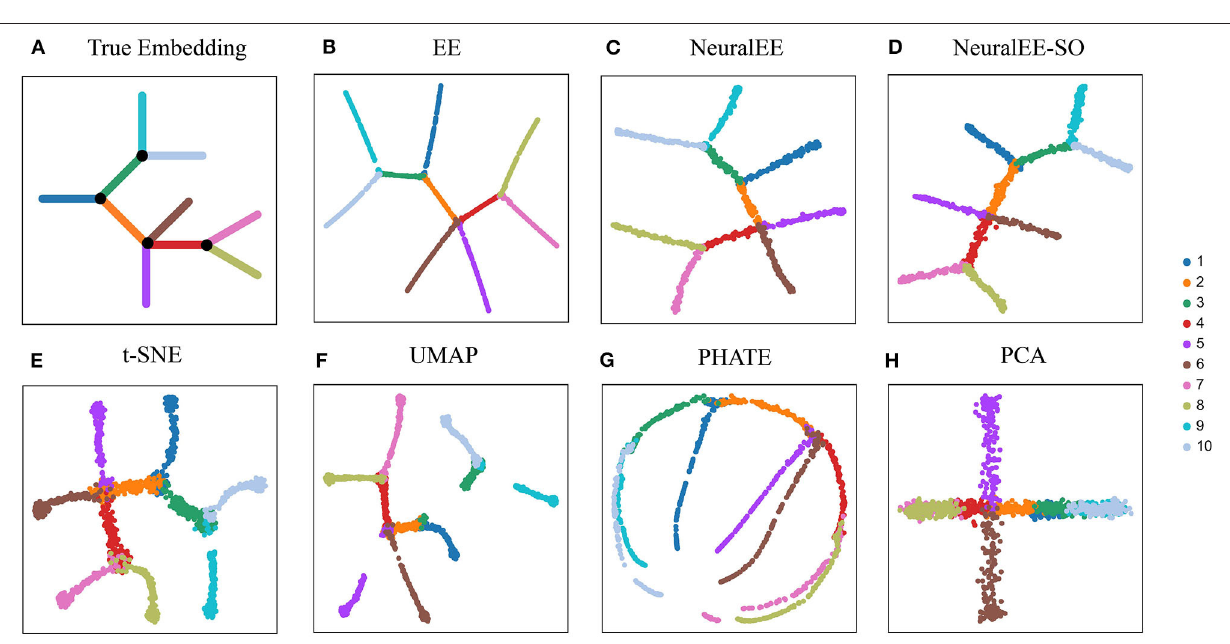
FIGURE 2 | Comparison of NeuralEE to other visualization methods on ArtificialTree data. (A) True embedding. (B) EE. (C) NeuralEE. (D) NeuralEE-SO. (E) t-SNE. (F) UMAP. (G) PHATE. (H) PCA. Different color corresponds different branch of artificial